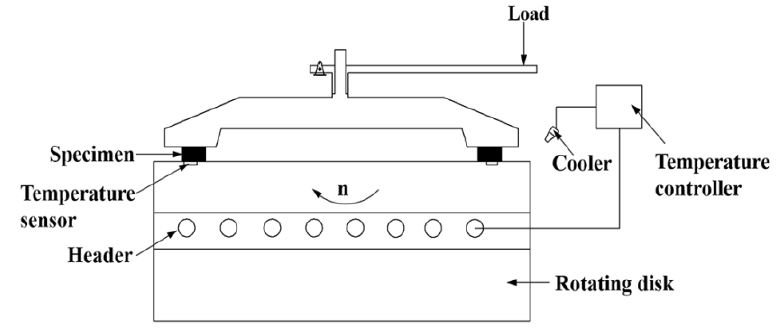
Figure 2. Schematic diagram of friction testing machine.